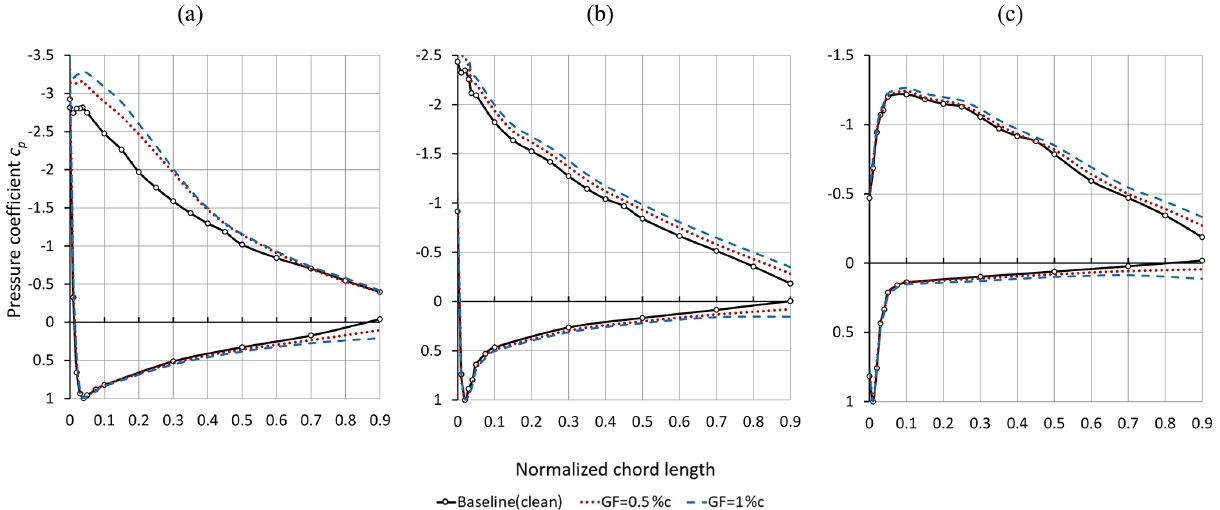
Figure A3. Pressure coefficients in the clean case with respect to different scales at r = 0.45 R and ϕ = 270 ◦ . (a) TSR = 3.0. (b) TSR = 4.3. (c) TSR = 5.6.